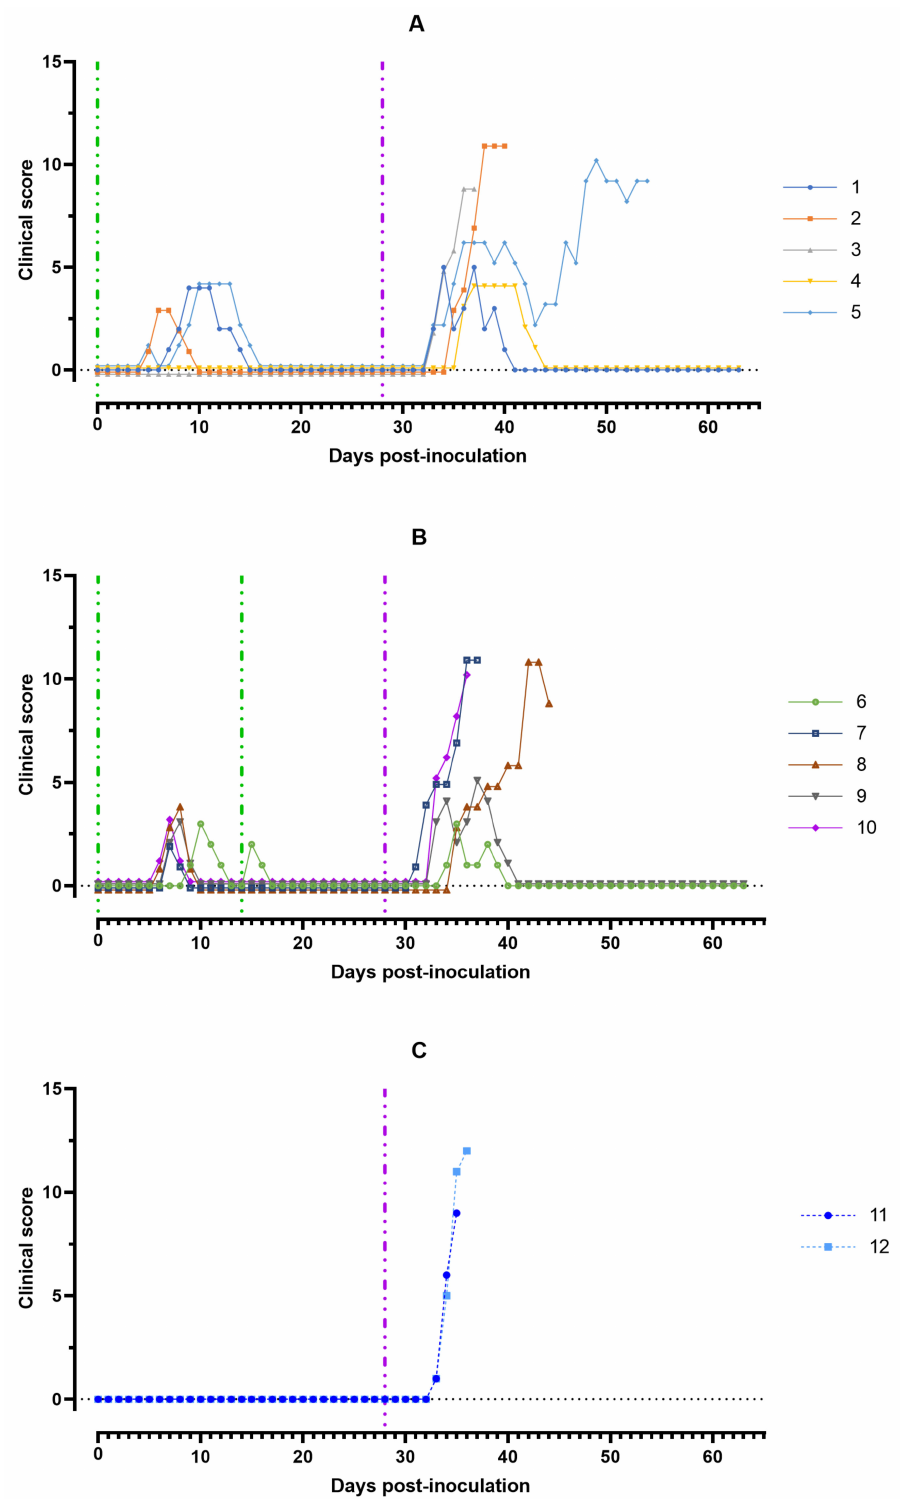
Figure 2. Clinical score of pigs: ( A ) group #1 after inoculation with the ASFV-Katanga-350 and challenge on the 28th day with the ASFV-Stavropol 01/08; ( B ) group #2 after two inoculations with the ASFV-Katanga-350 and challenge on the 28th day with the ASFV-Stavropol 01/08; ( C ) group #3 after challenge with the ASFV-Stavropol 01/08. Each curve represents an individual animal’s values. Vertical dashed lines: green—days of inoculation of ASFV-Katanga-350, purple —challenge by the ASFV–Stavropol